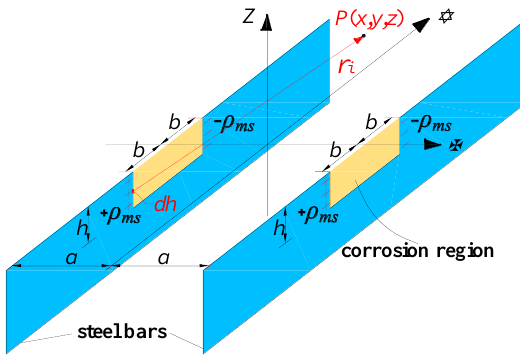
Figure 6. Calculated diagram based on the magnetic dipole model.